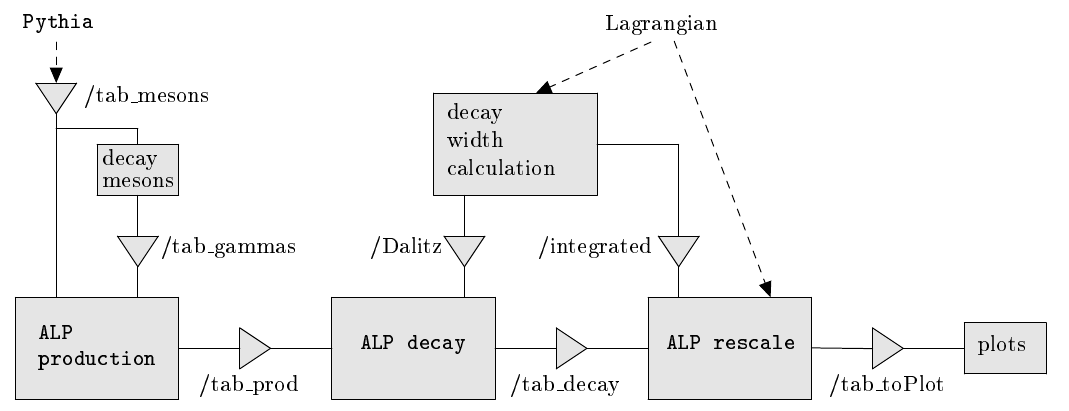
Figure 8 . Diagram representing the internal structure of the ALPINIST